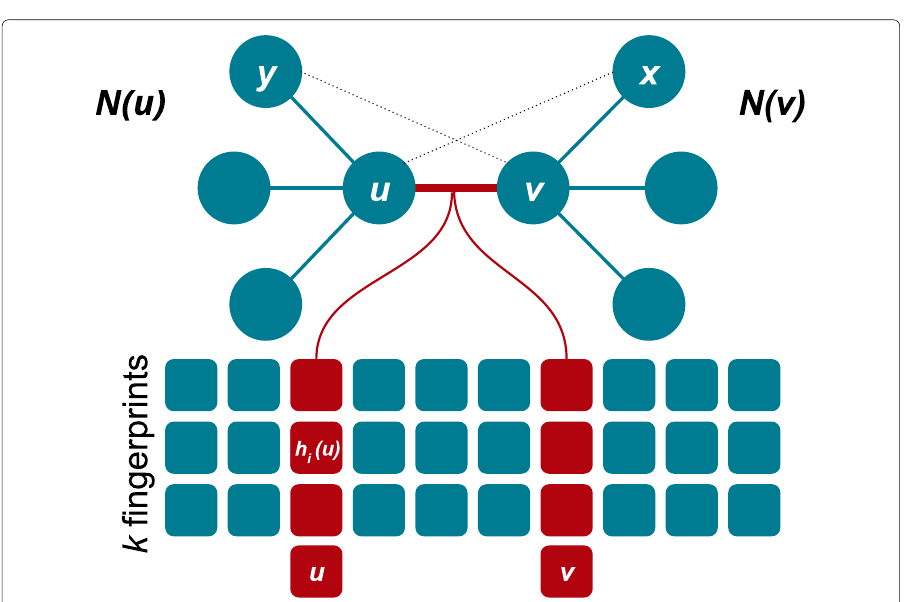
Fig. 6 Online learning of second order node